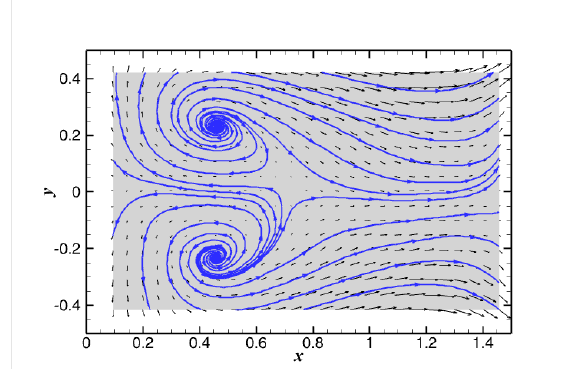
Fig. 4. The mean velocity field in the plane z = 0.8 .